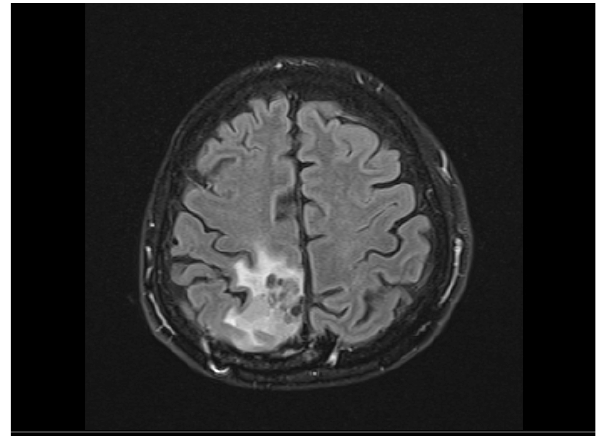
Fig. 3b. Diffusion-weighted MRI scan showing multilocal hy- persignal rim encompassing the resection cavity shown in 3a.